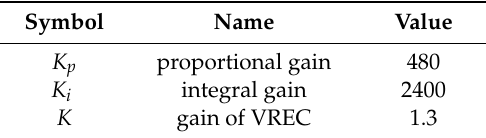
Table 3. Parameters of motor-side controller. Symbol Name Value